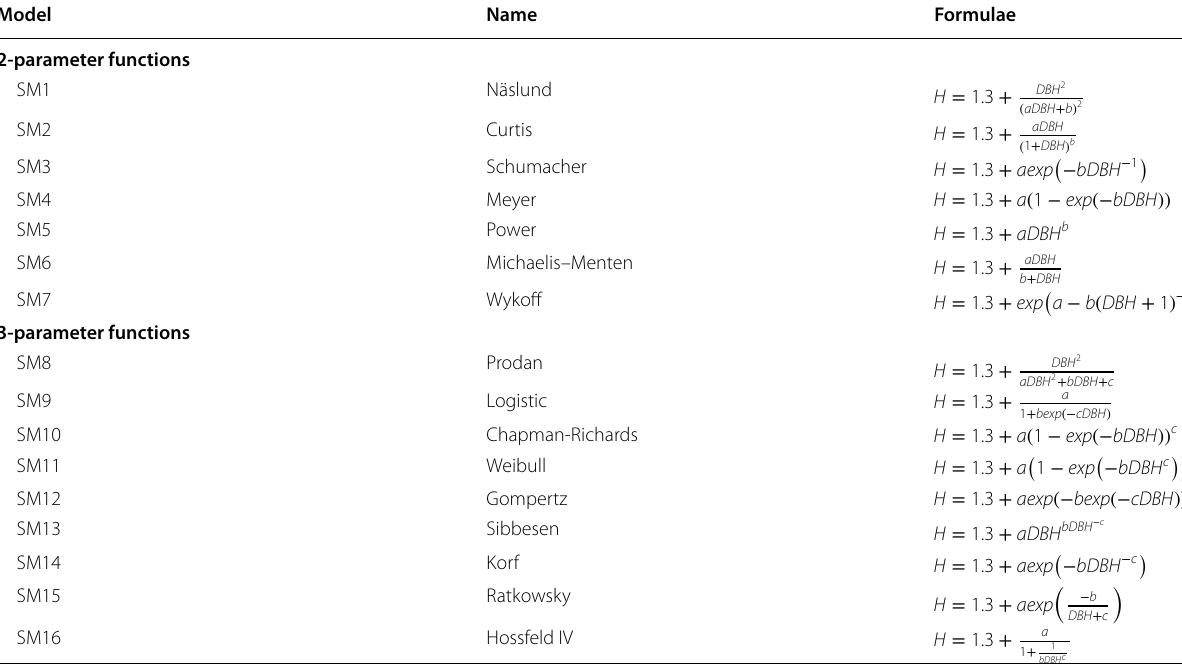
DBH diameter at breast height (cm), H total tree height (m), a , b , c model parameters